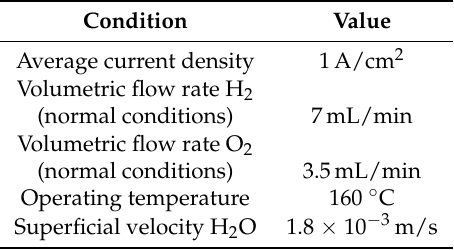
Table 1. Operating conditions. H 2 O is created as a vapor. The input to the LB algorithm are the species “H 2 O”, its temperature (for density and viscosity), and the velocity.